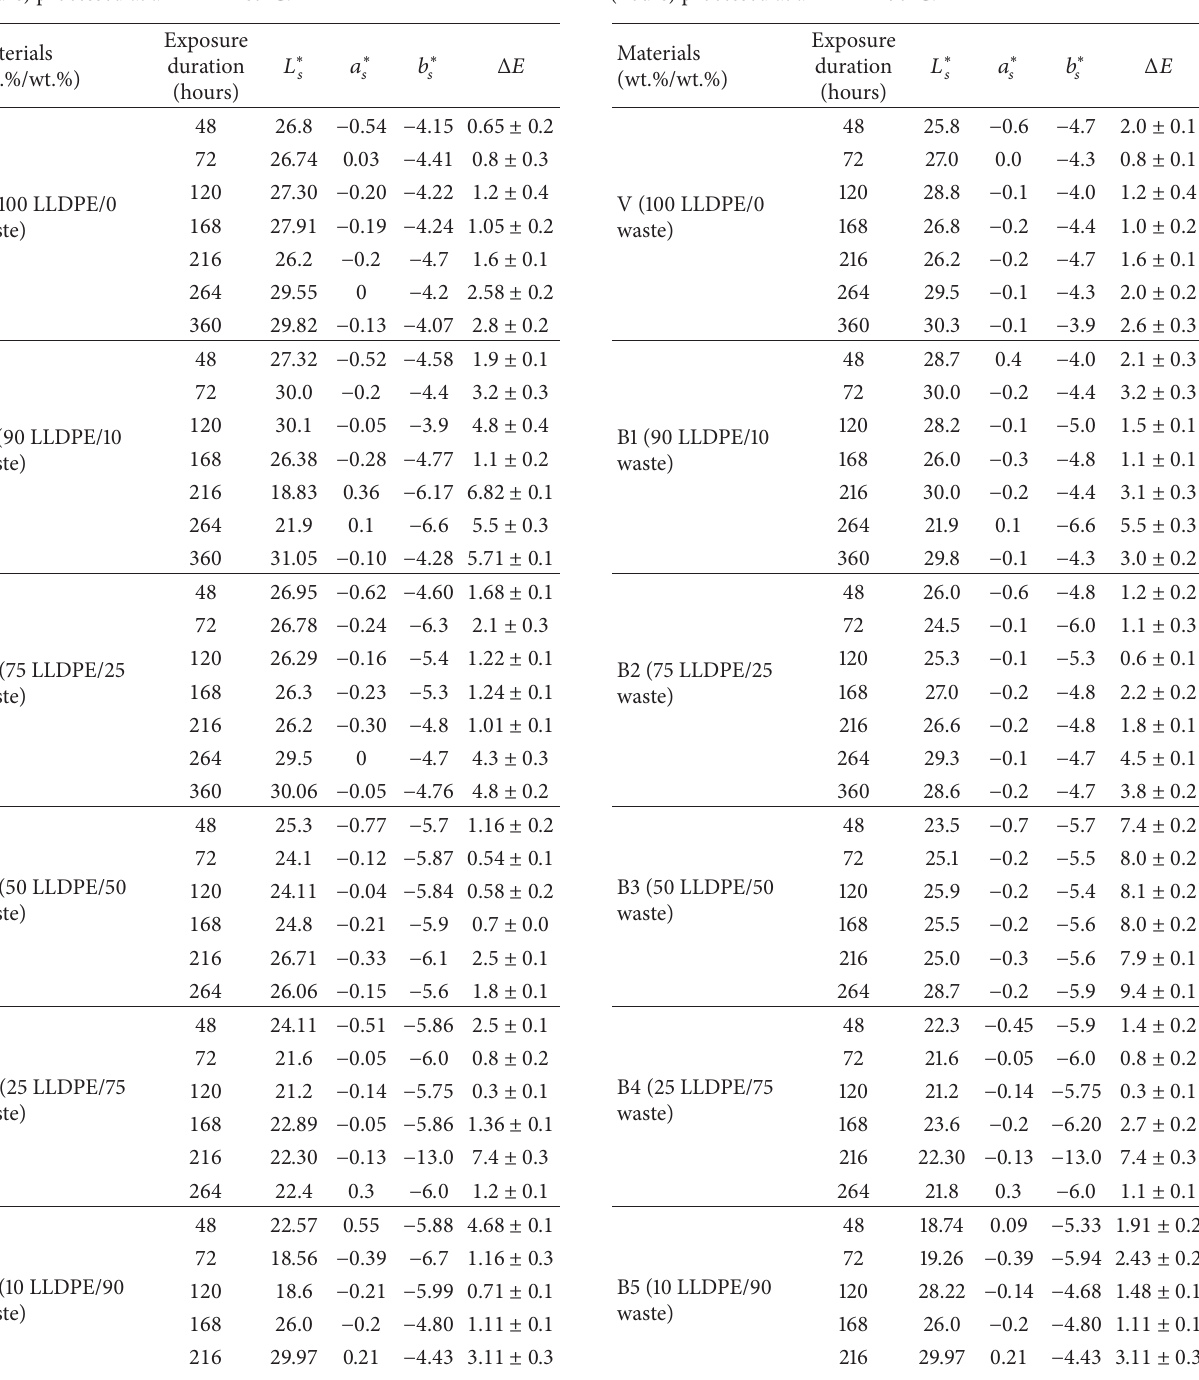
Table 3: Colour parameters and total change in colour ( Δ𝐸 ) for studied formulations at different accelerated weathering exposure (hours) processed at a DHT = 185 ∘ C.